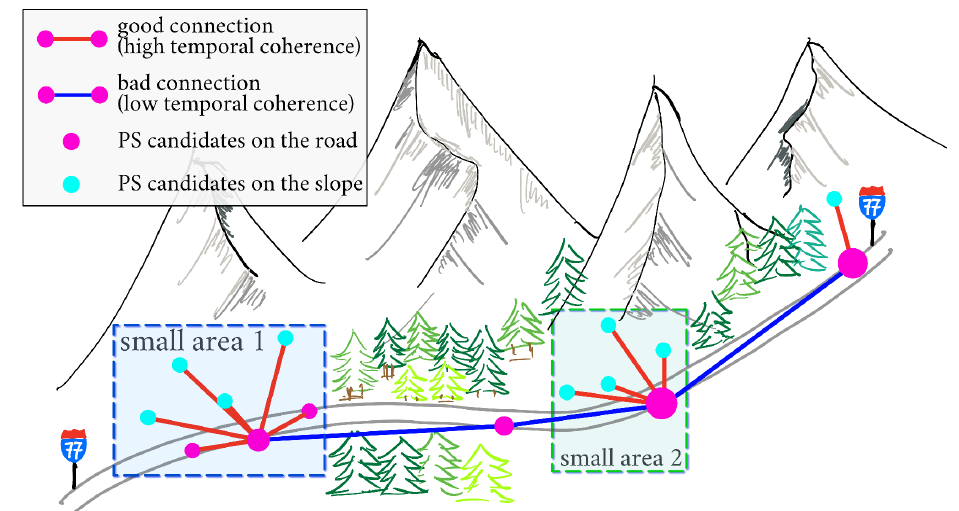
Figure 2. A visualization of the proposed MTInSAR processing method. All the persistent scatterers candidates from the same small area have good “connection” (in terms of temporal coherence) to the nearby reference point. However, the “connections” between different small areas might be bad due to the long distance (for the longer distance the effect of atmospheric phase screen (APS) comes to play) and the fewer connections. The solution is to split up the AoI into smaller areas. Each small area includes one slope and one reference point nearby. Each small area could be processed independently according to Section